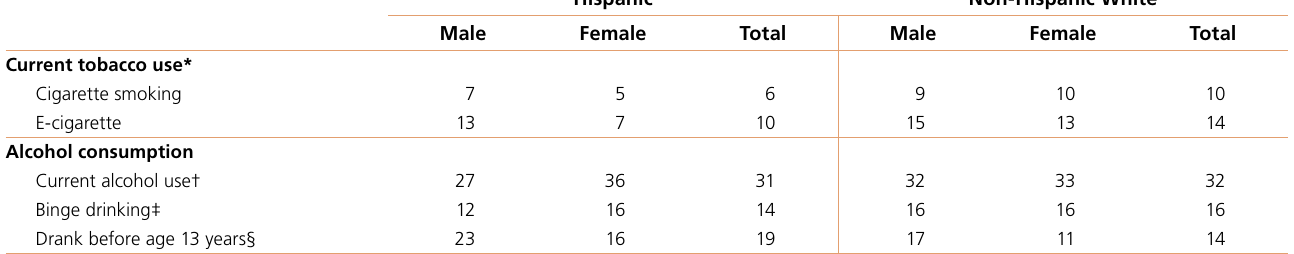
Table 7. Tobacco Use and Alcohol Consumption (%), High School Students, US,